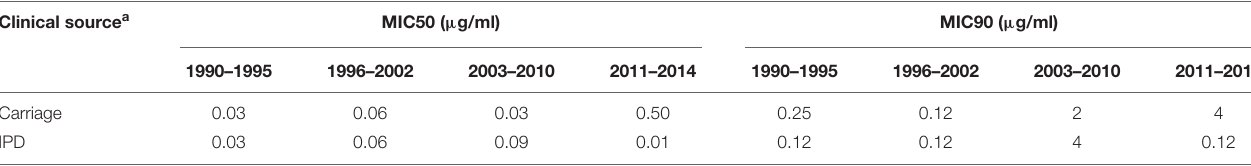
Clinical source